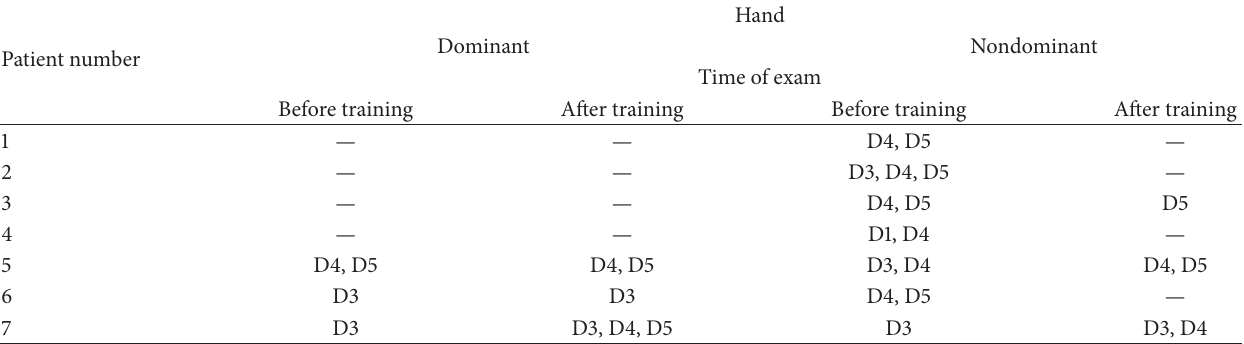
Table 2: Tactile sensation of fingers before and after training. The fingers with abnormal sensitivity are indicated (D1: thumb, D2: index finger, D3: middle finger, D4: ring finger, and D5: little